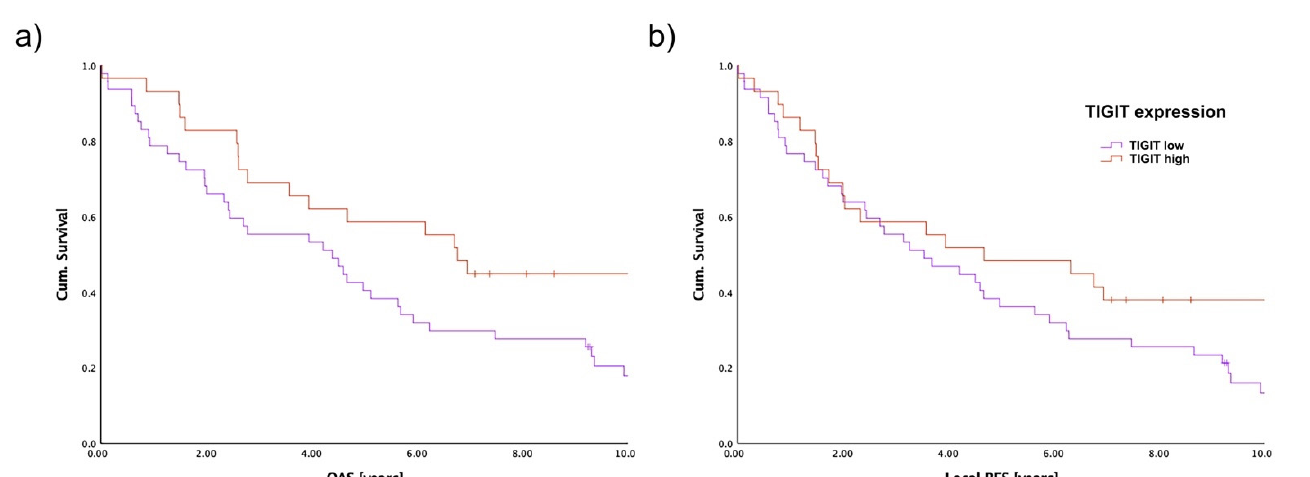
Figure 4. Survival of OSCC patients based on TIGIT expression on CD3+ intratumoral cells assessed by immunostaining of TMA slides. The patient cohort was separated by a median cutoff. ( a ) OAS in the complete cohort ( n = 76, p = 0.025); ( b ) local RFS ( n = 76, p = 0.129); ( c ) locoregional RFS ( n = 76, p = 0.080); ( d ) distant RFS ( n = 76, p = 0.026). 4. Discussion The aim of this study was to characterize the expression levels of TIGIT in OSCC on gene and protein levels and evaluate its prognostic role. Therefore, we systematically searched online databases containing data from OSCC patients. In silico data revealed a significant association of high TIGIT mRNA expression levels with high CD274 mRNA expression levels and favorable OAS. At the protein level, the effect of TIGIT on OAS corroborated with online data. Patients with higher levels of TIGIT on CD3+ cells had a significantly higher 5 − year survival rate. Additionally, high TIGIT expression on CD3+ cells was associated with longer RFS concerning distant metastasis. In terms of the underlying mechanism of TIGIT antibodies, two main antitumorigenic effects are taken into consideration when pharmacologically blocking the TIGIT signaling axis. The main driver of the reinstatement of antitumor activity seems to be the restoration of CD8+ T cells. Despite ambiguous data in the literature, it is generally accepted that a tumor − associated T − cell pool consisting of mainly CD8+ cells is responsible for combating cancer [24]. Results in pre − clinical cancer models show increased activity of CD8+ effector T cells when interfering with TIGIT and PD − 1 or PD − L1 simultaneously [18,25]. The second mechanism that was observed was the decrease in